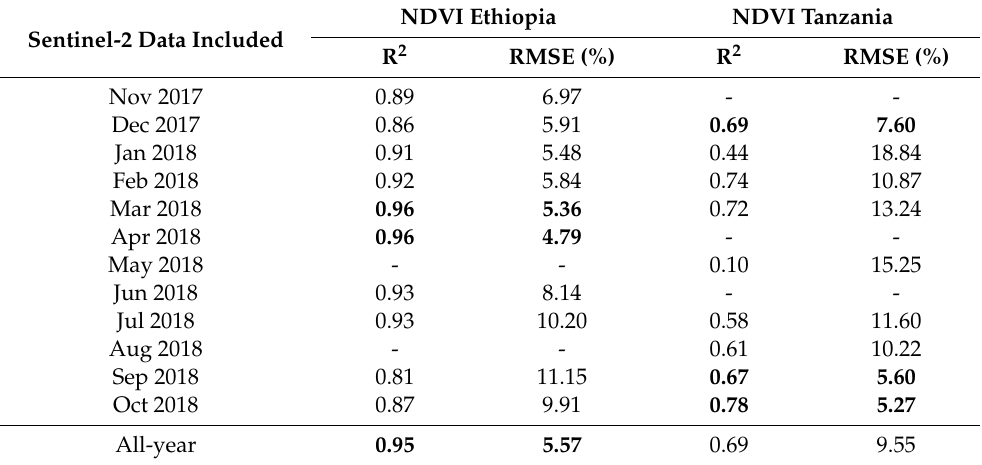
Table 4. Coe ffi cient of determination (R 2 ) and root mean square error (RMSE) of the linear regression models for Ethiopia and Tanzania separately (Scenario 1). ‘-‘ means some plots were covered by clouds so R 2 and RMSE could not be calculated. In the all-year-regression in Ethiopia, May and August 2018 were left out, while in Tanzania, November 2017 and April and June 2018 were left out. The three best performing models for each study site are marked in bold.